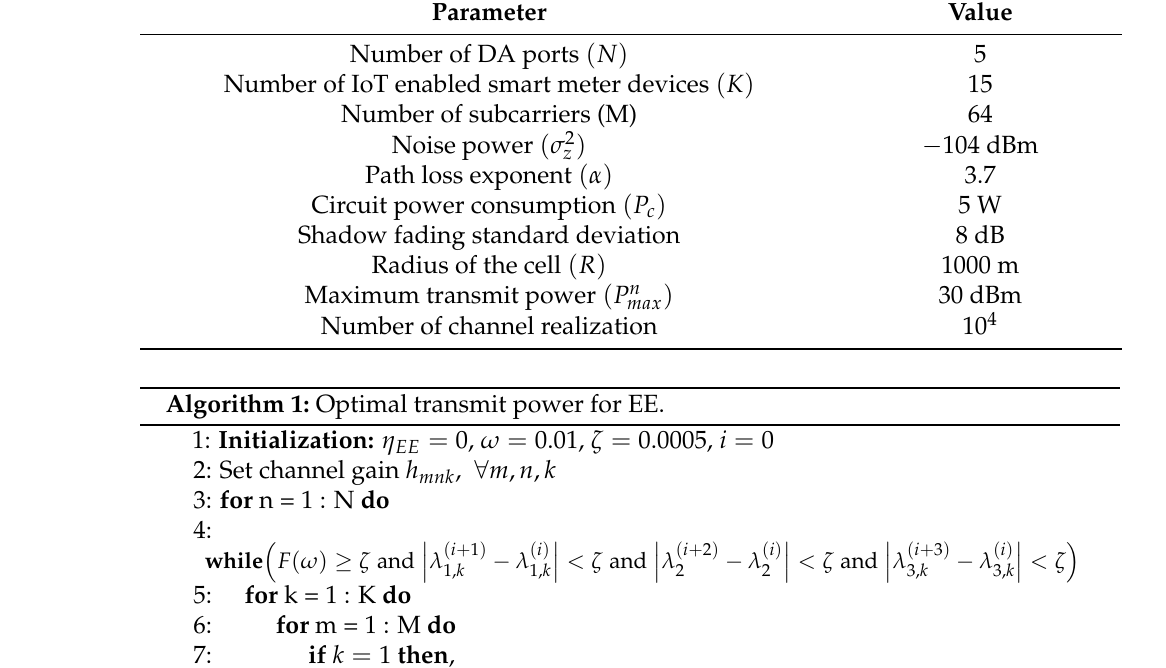
Table 2. Simulation Paramters.